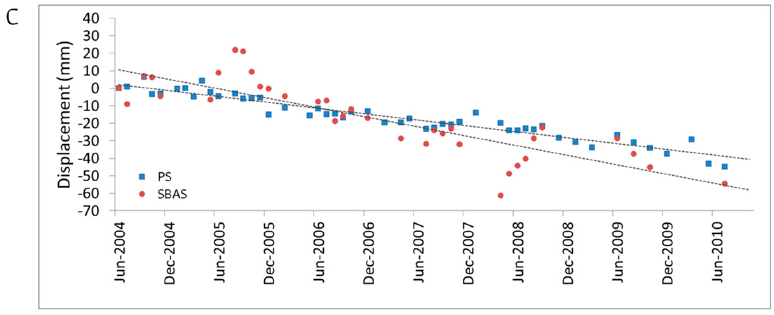
Figure 13. Comparison between the Envisat ascending ( A ) GPOD-SBAS results and the ( B ) PSInSAR results (from the Portale Cartografico Nazionale) over the Quart DsGSD; ( C ) time series corresponding to the SBAS target and the PS, signified respectively by the black square in ( A ) and by the red square in ( B ) within the Quart DsGSD phenomenon.